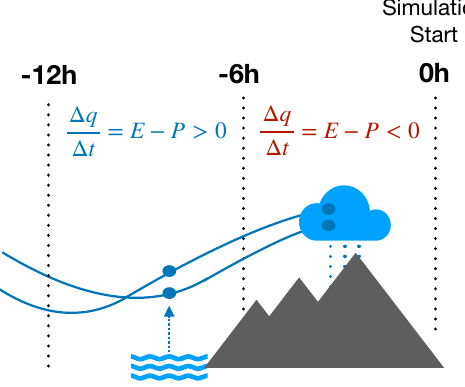
Figure 2. Source and sink calculation of the parcel trajectories as individual parcels move backward in time. The dotted arrow indicates a regional source of moisture for a parcel as a result of evaporation (i.e., E − P is positive). The cloud shows parcels losing net moisture (sink) by precipitation (i.e., E − P is